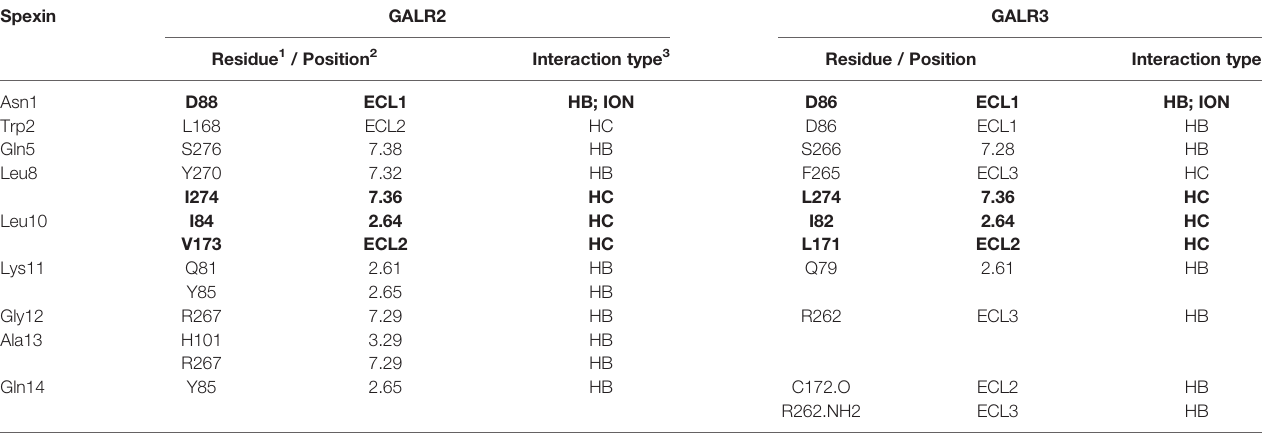
TABLE 2 | Predicted interactions between SPX and